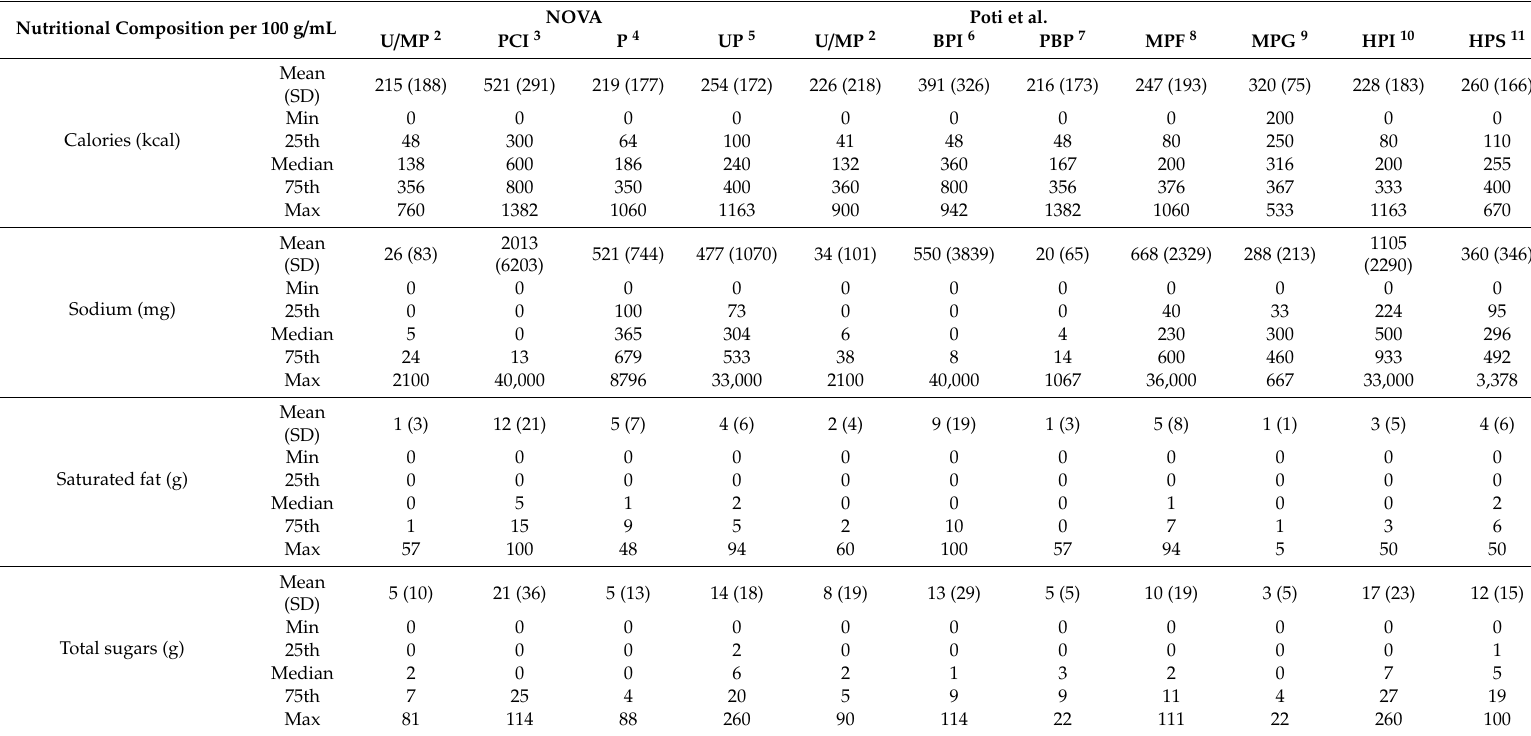
Table 2. The distribution of calories, sodium, saturated fat, total sugars, free sugars, fibre and protein per 100 g (or 100 mL) in each category of the NOVA and Poti et al. food processing classification systems, presented for the total sample of packaged food and beverage products ( n = 17,269) 1